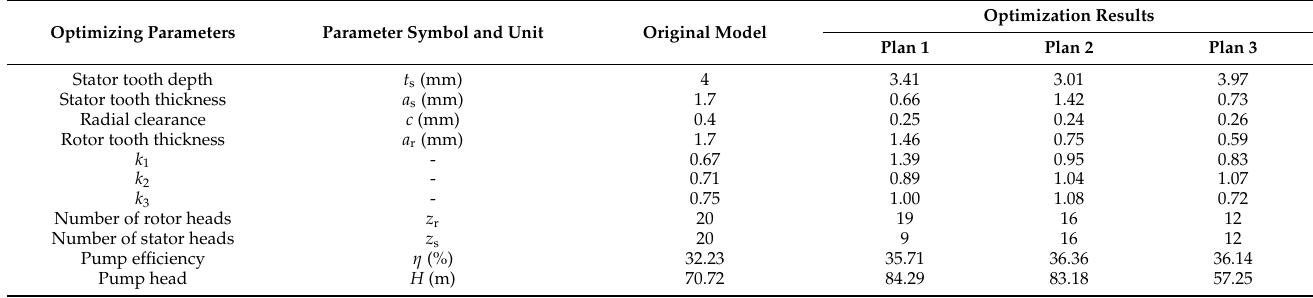
Figure 16. Response surfaces showing the effects of the interactions between the stator tooth depth t s , the number of rotor heads z r , and k 3 on the pump head and efficiency of the labyrinth screw pump; ( a , d ) show the influence of t s and k 3 on pump head and efficiency; ( b , e ) show the influence of ts and zr on pump head and efficiency; ( c , f ) show the influence of k 3 and z r on pump head and efficiency. Table 4. Comparison of optimized design schemes.